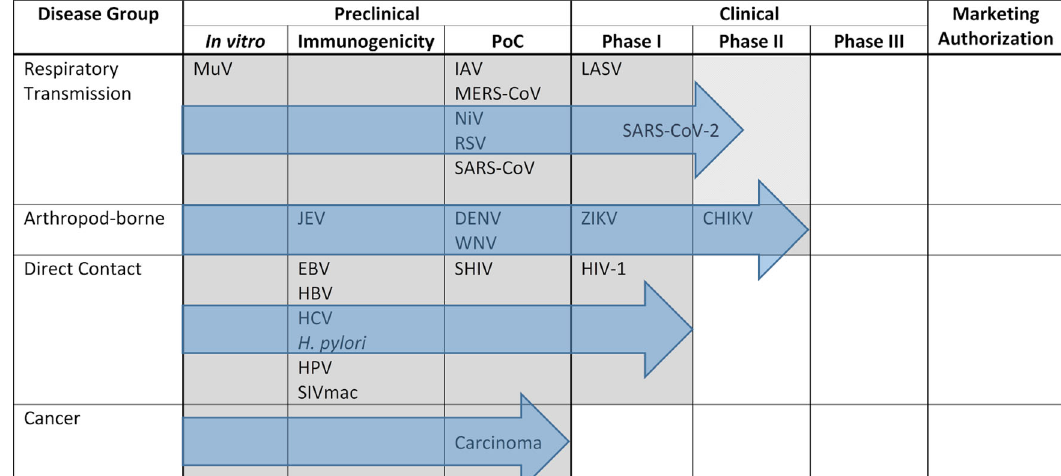
Fig. 2 Progression diagram of current state of MeV-derived vaccine development. Depiction of progress of MeV-derived vaccines´ development targeting pathogens from groups of diseases differentiated by their mode of transmission. Outlined are the different preclinical and clinical developmental stages of vaccine development until marketing authorization. Position of the pathogens indicate most advance development of a vaccine candidate against this pathogen. Gray areas and blue arrows depict progress of the most advanced vaccine candidate directed against one pathogen out of the respective disease group. PoC, proof of concept in animal challenge